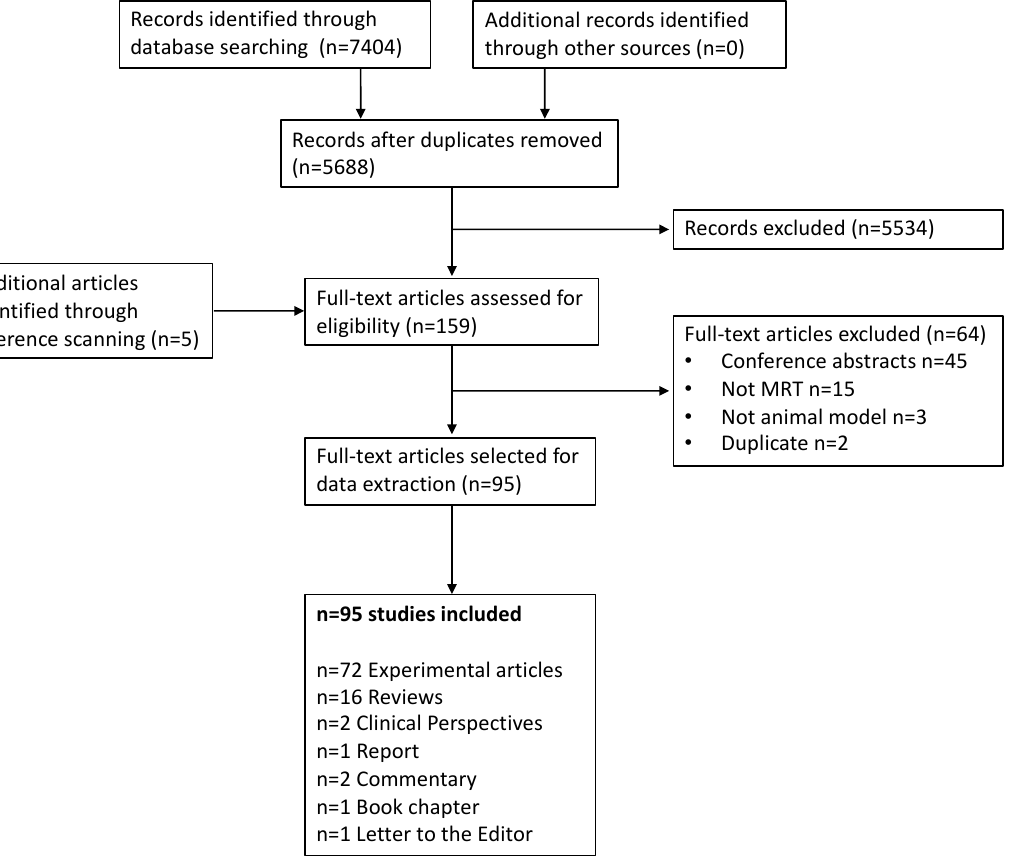
Figure 2. Study Flow. Details of the flow of information during the study .